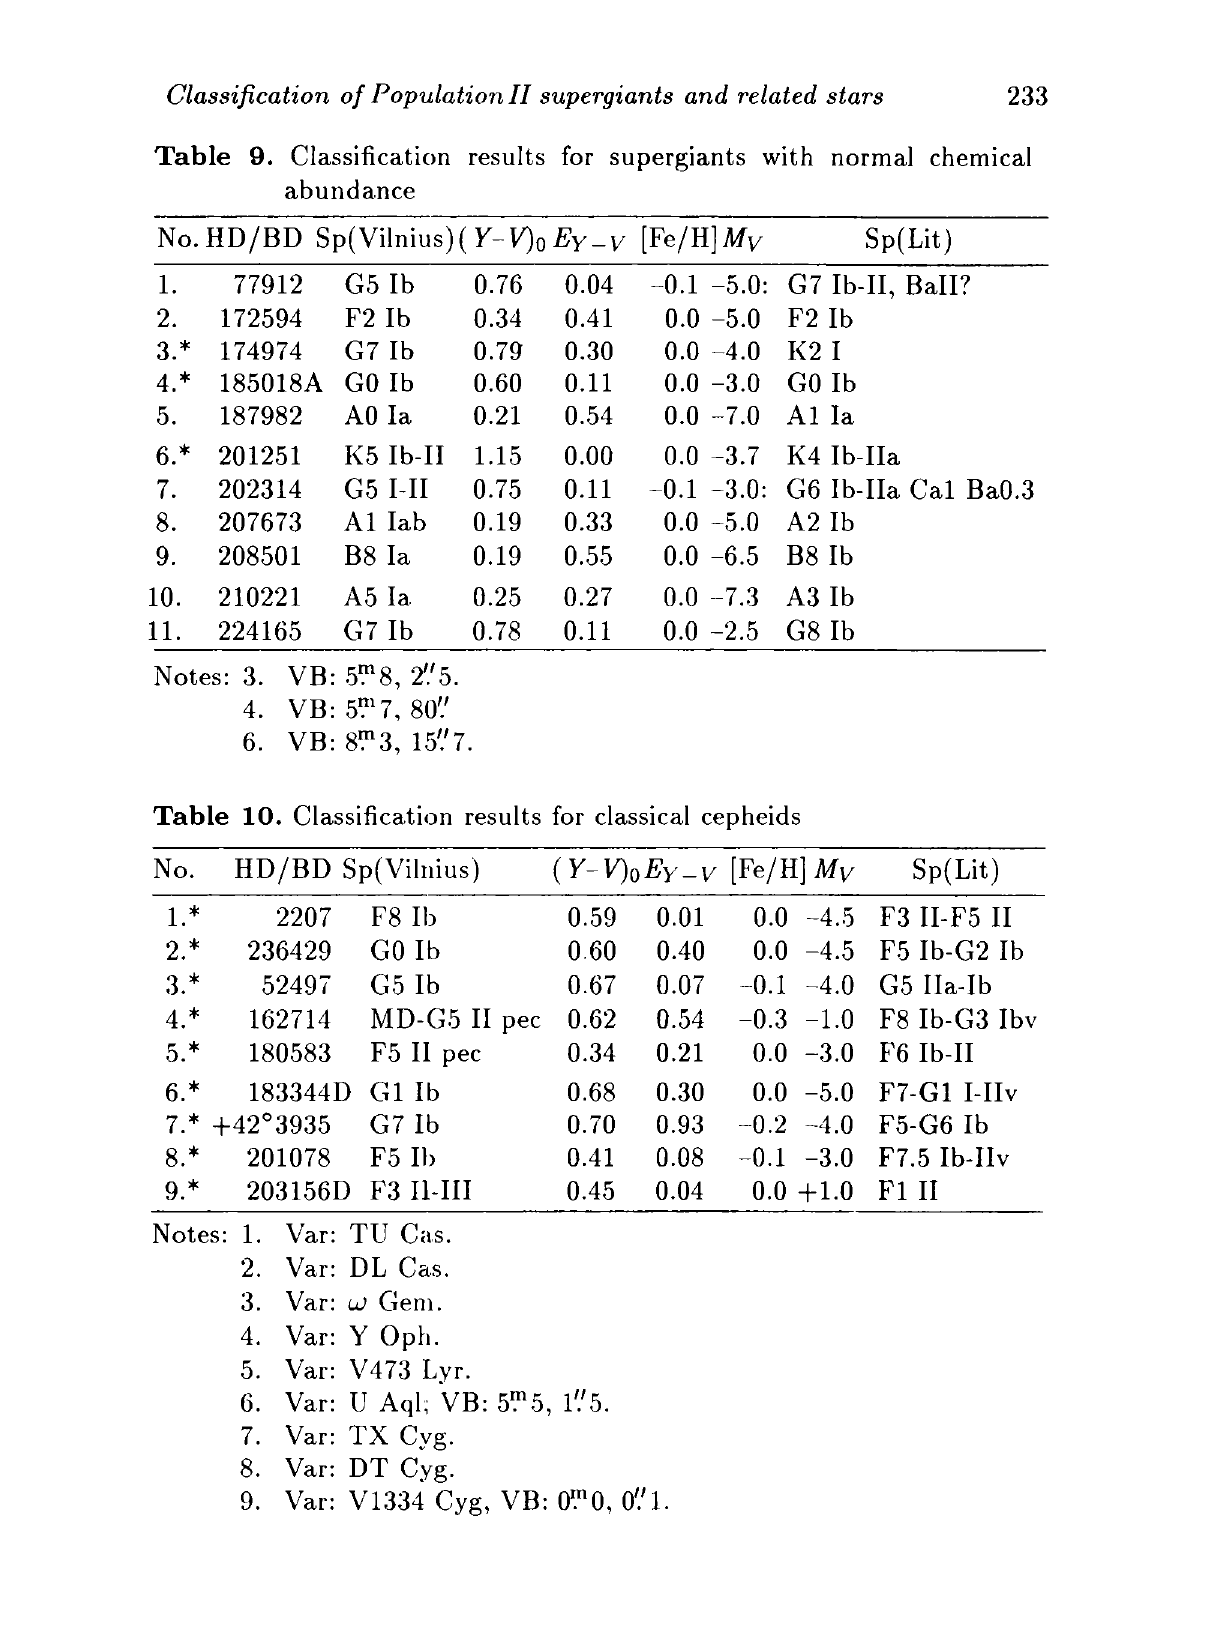
Table 9. Classification results for supergiants with normal chemical abundance